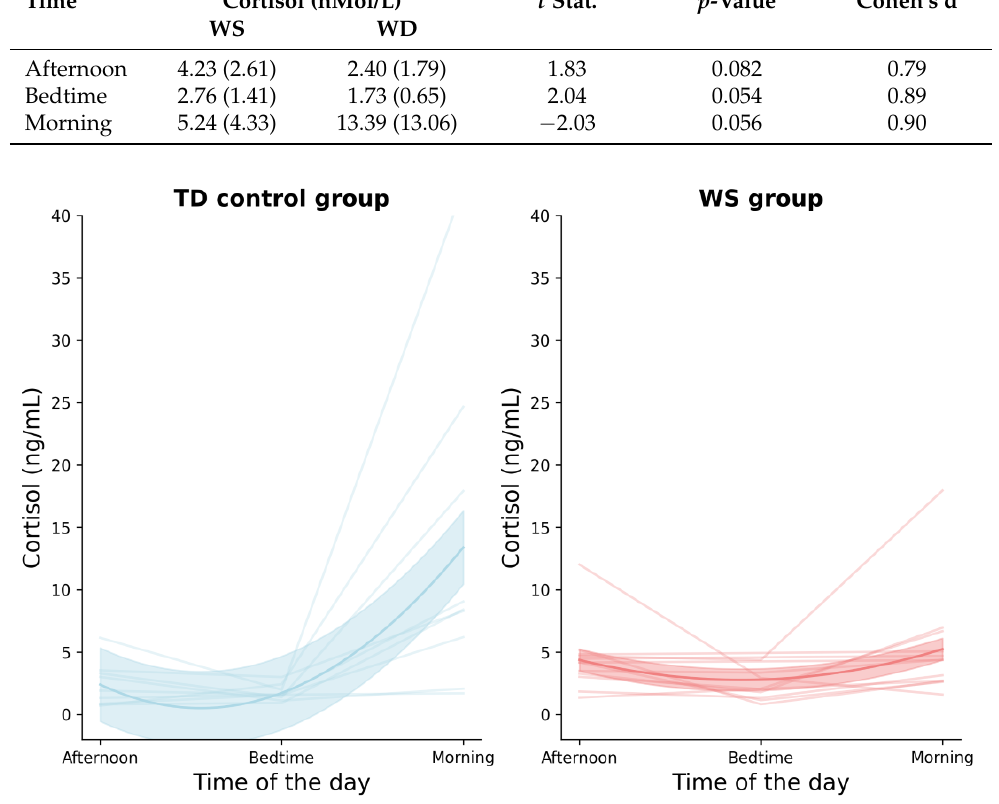
Figure 1. Plot depicting cortisol concentration for TD and WS groups across three time points: baseline (afternoon), bedtime, and morning. Note: each line in the graphs represents data from a unique